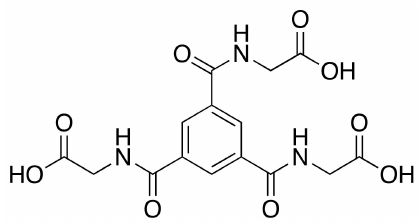
Figure 17. H 3 L 1 , the ligand used in the study.